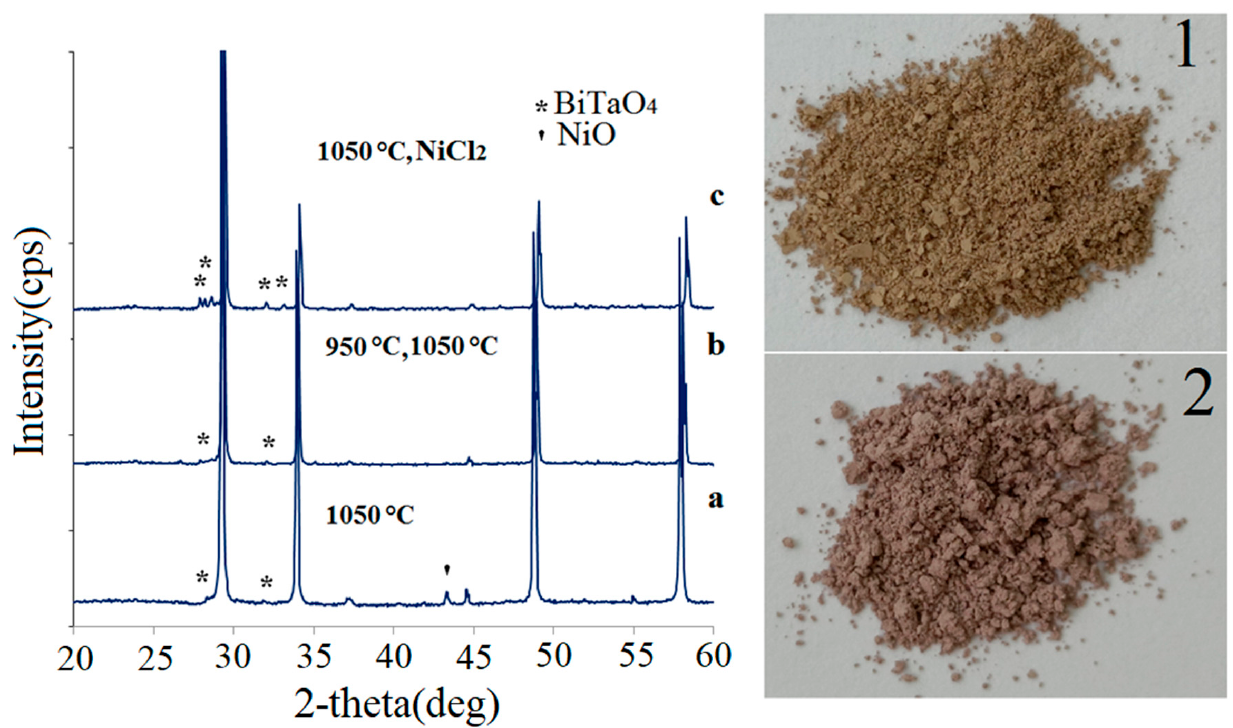
Figure 1. X-ray powder diffraction patterns of Bi 2 NiTa 2 O 9 samples synthesized from BiTaO 4 and NiO in one stage at 1050 °C ( a ) and in two stages at 950 and 1050 °C ( b ), using the NiCl 2 precursor ( c ); photographs of Bi 2 NiTa 2 O 9 samples synthesized from ( 1 ) NiCl 2 and ( 2 ) oxides.